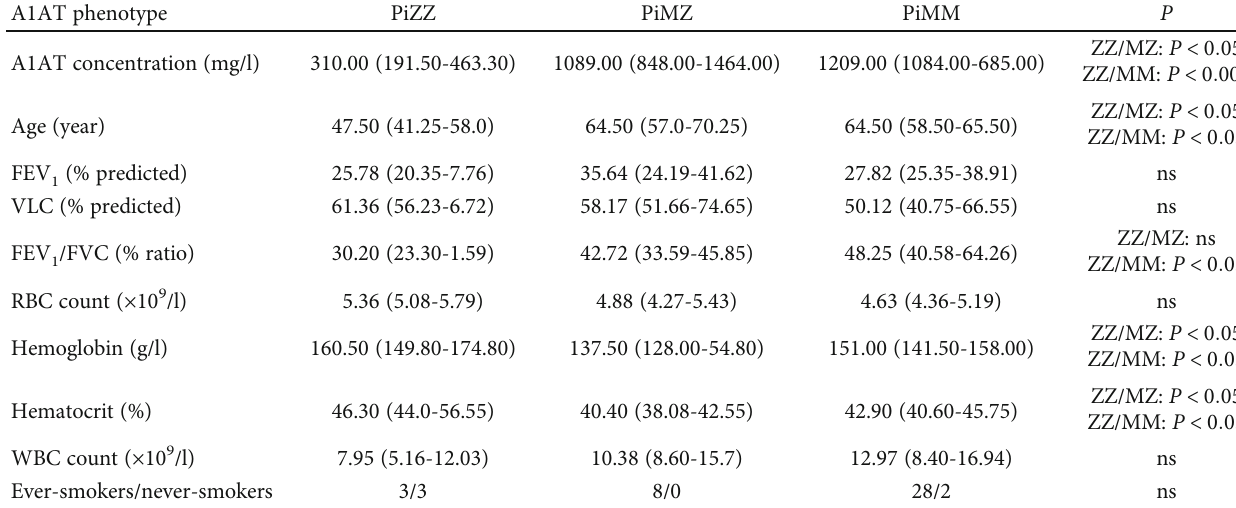
Table 1: Clinical and laboratory parameters of groups of COPD patients, divided by the A1AT phenotype.